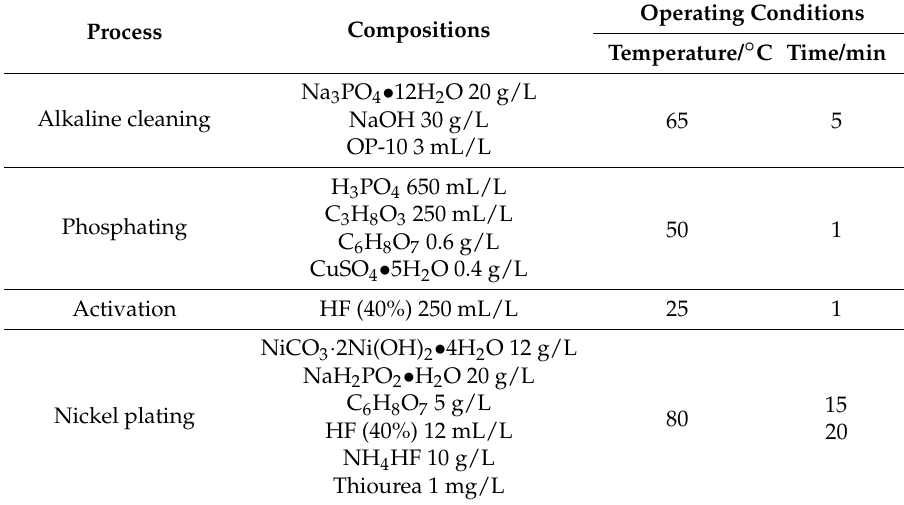
Table 1. Bath Compositions and operating conditions of each process for Ni-P